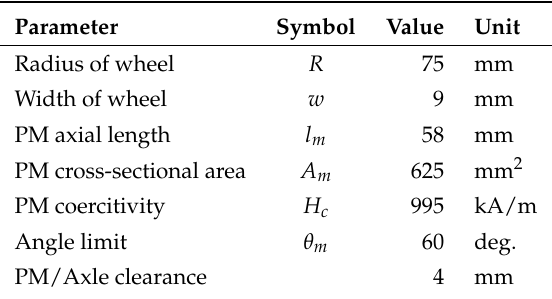
Table 1. Parameters of the magnetic